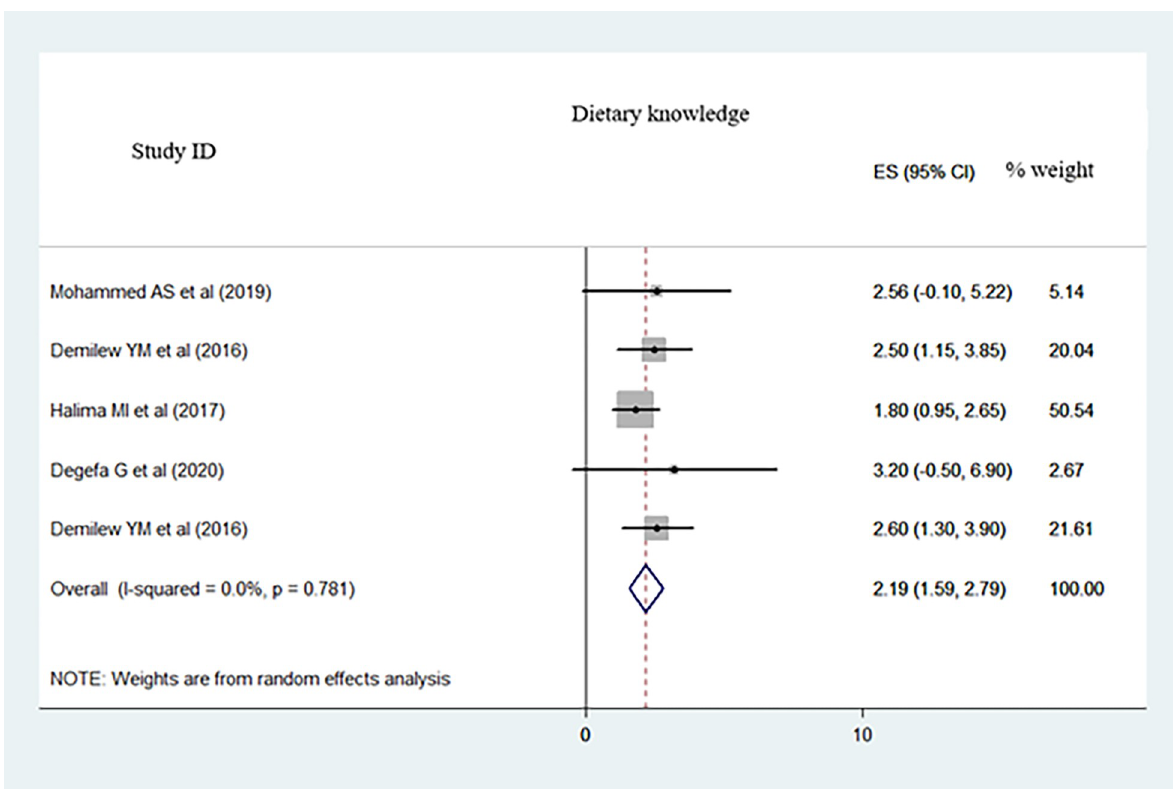
Fig 7. A meta-analysis of dietary knowledge associated with dietary adherence among type 2 DM population in Ethiopia.